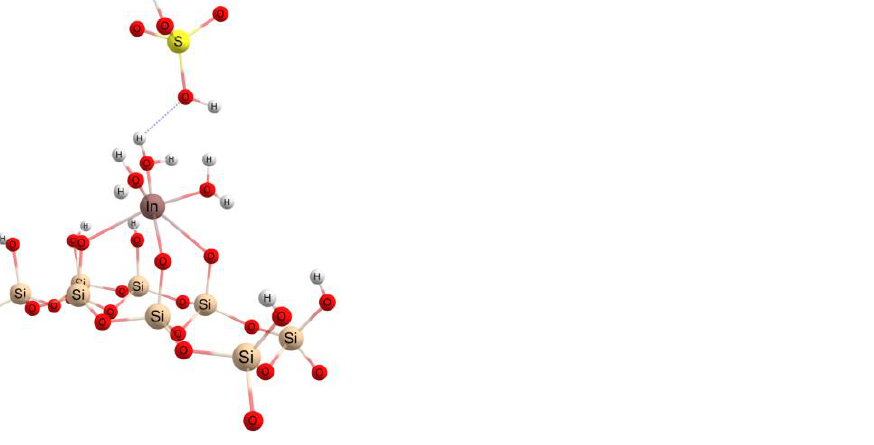
Figure 10. The interaction of the In structure with the SBA-15 surface and formation of three In – OSi covalent bonds.